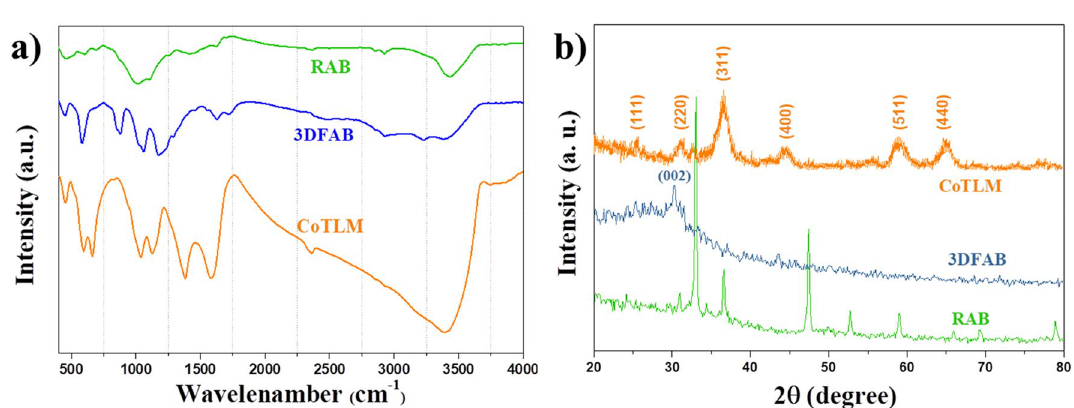
Figure 2. FT-IR spectra ( a ) and XRD patterns ( b ) of RAB, 3DFAB,